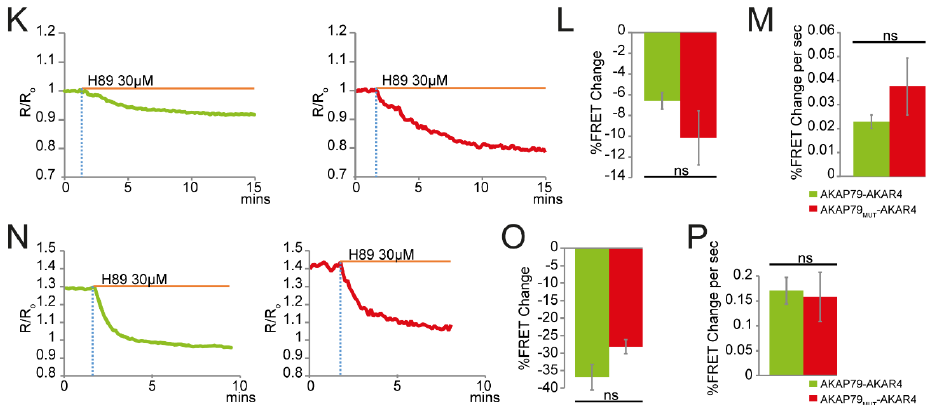
Figure 2. Effect of using AKAP79 as a targeting domain for AKAR4 on detection of PKA activity. ( A ) Schematic representation of the targeted AKAR4 sensor. Stars indicate the region where the mutations were introduced in AKAP79 Mut -AKAR4. FHA1 is the phospho-amino acid binding domain. LRRATLVD is the PKA phosphorylation consensus sequence domain. Cerulean is the cyan fluorescent protein and YFP is the yellow fluorescent protein; ( B ) Confocal images showing the predominant localization of AKAP79-AKAR4 and AKAP79 Mut -AKAR4 at the plasmalemma of NRVMs. Scale bar is 10 μm; ( C ) Western blot analysis showing co-immunoprecipitation of PKA RIIα with AKAP79-AKAR4 and AKAP79 Mut -AKAR4 in NRVMs. WCL is whole cell lysate. AKAR4 [29], a cytosolic version of the PKA activity sensor, was used as a control; Western blot analysis showing co-immunoprecipitation of AKAP79-AKAR4 ( D ) and AKAP79 Mut -AKAR4 ( E ) with endogenous AC5/6 in NRVMs. Ctrl beads indicate the pulldown with beads without the GFP-trap_A; Representative kinetics ( F ) and summary of amplitude ( G ) of FRET change on application of 0.05 nM Isoproterenol (Iso) followed by Rolipram (Roli) 10 μM in NRVMs expressing either AKAP79-AKAR4 (green) or AKAP79 Mut -AKAR4 (red). ① is Iso max; ② is Iso plateau; ③ is Roli max after iso plateau; ④ is Roli plateau over Iso plateau; and ⑤ is saturating stimulus (SAT) of 25 μM forskolin + 100 μM IBMX; ( H ) Summary of the rate of FRET change on application of isoproterenol. For experiments shown in F – H , n ≥ 13; Representative kinetics ( I ) and summary ( J ) of FRET change on application of Roli (10 μM) in NRVMs expressing either AKAP79-AKAR4 or AKAP79 Mut -AKAR4. Striped bar in red represents plateau level of PKA activity reached on decay of the signal after the peak response. SAT indicates saturating stimulus (forskolin 25 μM + IBMX 100 μM). n ≥ 18; Representative kinetics ( K ) and summary of amplitude ( L ) and rate ( M ) of FRET change on application of H89 30 μM to otherwise unstimulated cells. n ≥ 12; Representative kinetics ( N ) and summary of amplitude ( O ) and kinetics ( P ) of FRET change on application of H89 30 μM after maximal PKA activation in NRVMs expressing AKAP79-AKAR4 (in green) and AKAP79 Mut -AKAR4 (in red). n ≥ 8. For all datasets, at least three biological replicates (independent myocyte isolations). For all experimental sets, data is presented as mean ± s.e.m. For statistical analysis, Student’s t -test was used except for G, where one-way ANOVA with post hoc correction test was used.